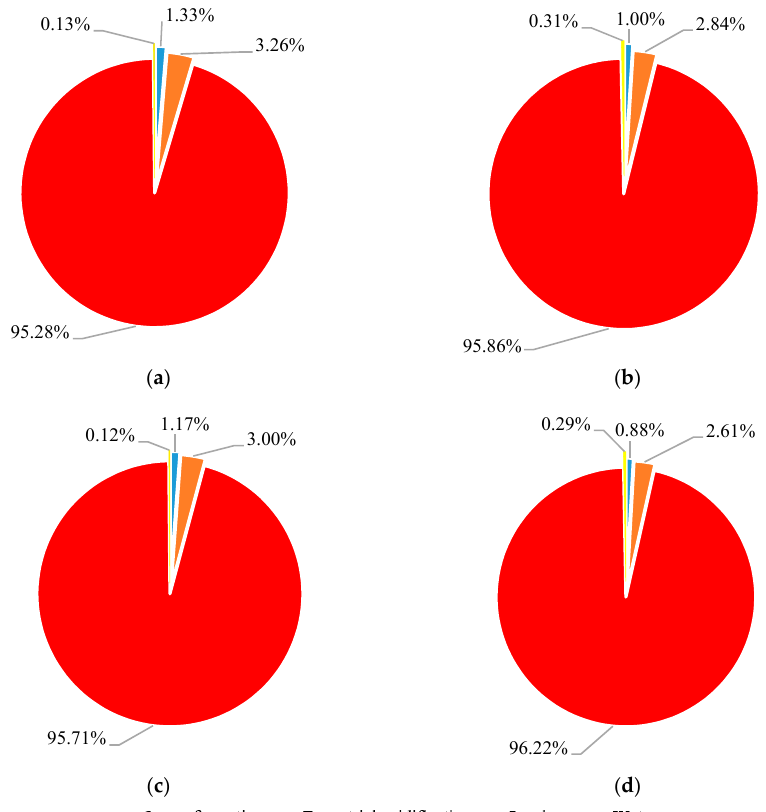
Figure 4. Terrestrial biodiversity of 1 kg of hemp shiv, based on regionalised and generic (world average) CFs for hierarchist perspective. ( a ): Regionalized values and economic allocation; ( b ): Generic values and economic allocation; ( c ): Regionalized values and mass allocation; ( d ): Generic values and mass